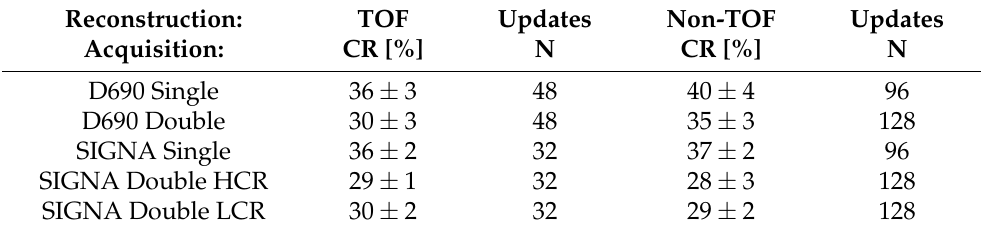
Table 7. Contrast recovery for the 7 mm sphere using the proposed CR matching rule.